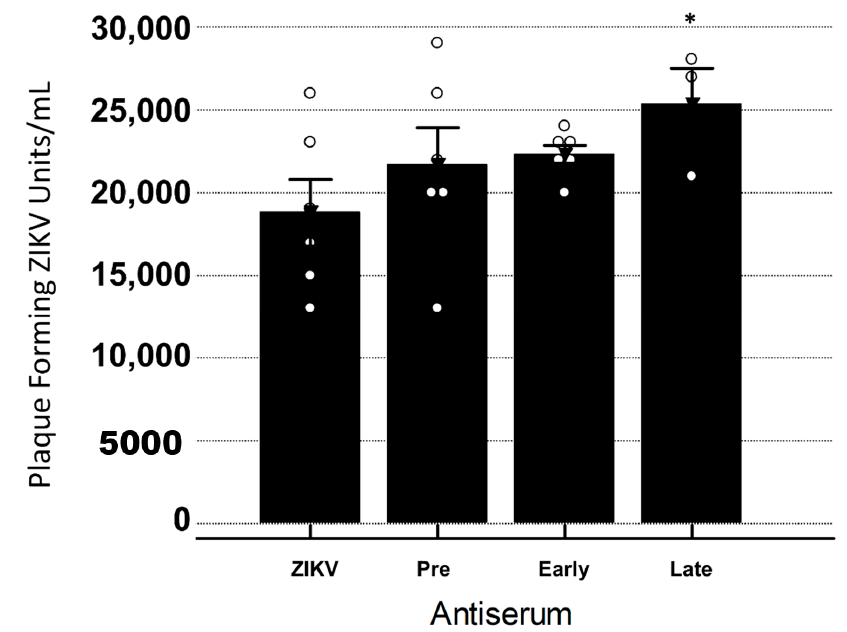
Figure 4. YFV antiserum neutralization / enhancement of ZIKV in Vero cells. Bars signify average plaque-forming units per mL ± standard error. Dots represent individual data points for the treatment.